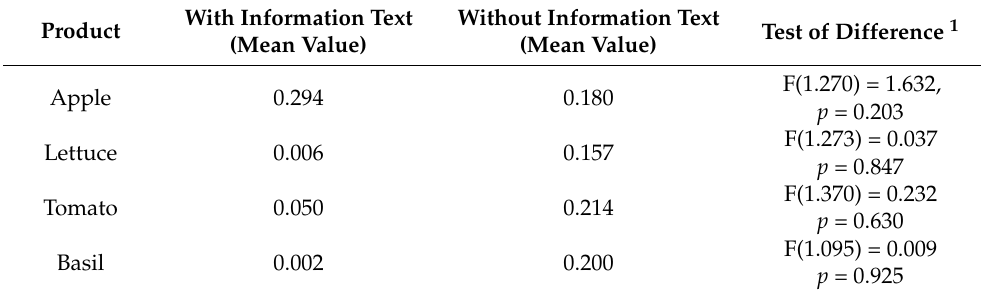
Table A5. Differences in price willingness between group A with information on the importance of iodine and group B without this information. n =